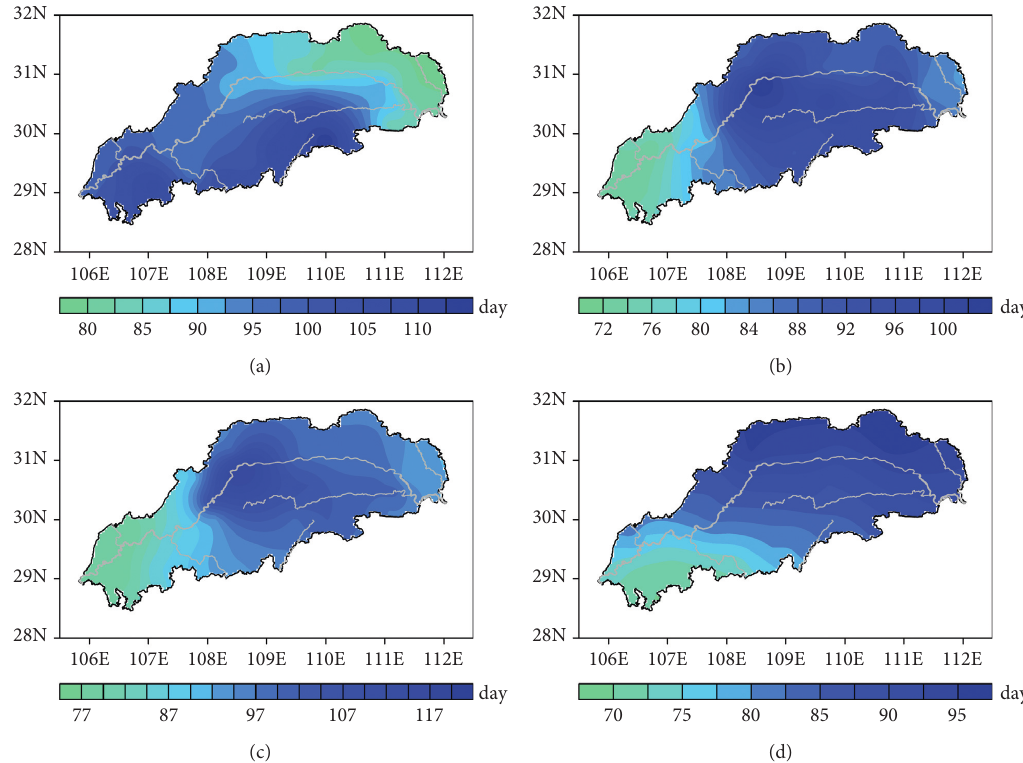
Figure 17: The spatial distribution of annual mean rainy days (based on the rainfall amount greater than or equal to 1mm) in (a) gauge observation, (b) TRMM, (c) CMORPH, and (d)